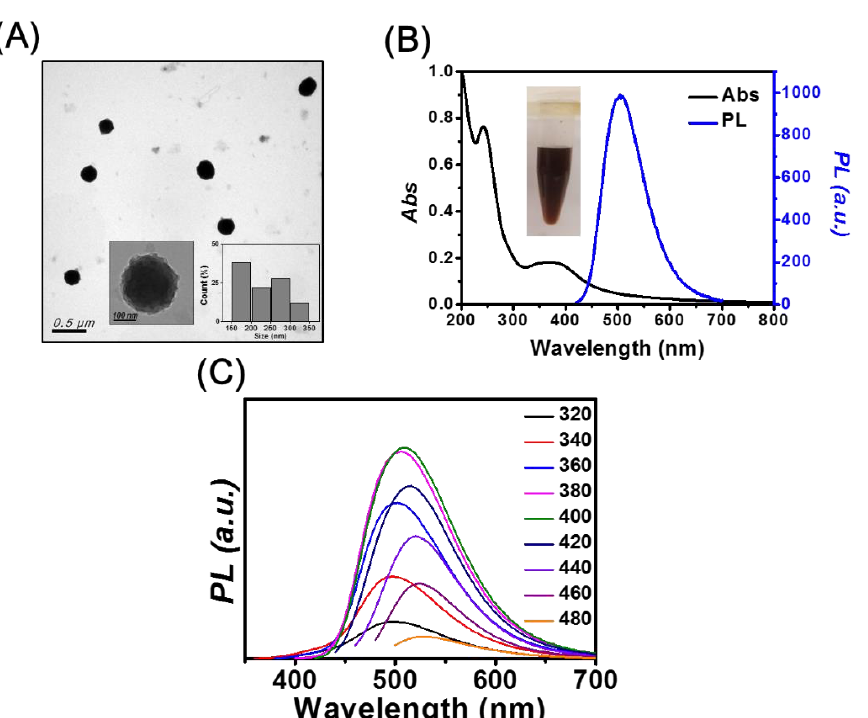
Figure 1. ( A ) TEM image of mPA CNPs. Inset: high resolution TEM image and size distribution analysis. ( B ) UV-Vis absorption and fluorescence spectra of m- PD CDs excited at 400 nm. Inset: photograph of 1 mg mL − 1 mPA CNPs solution. ( C ) Fluorescence spectra of mPA CNPs in aqueous solution as a function of excitation wavelength from 320 to 480 nm.